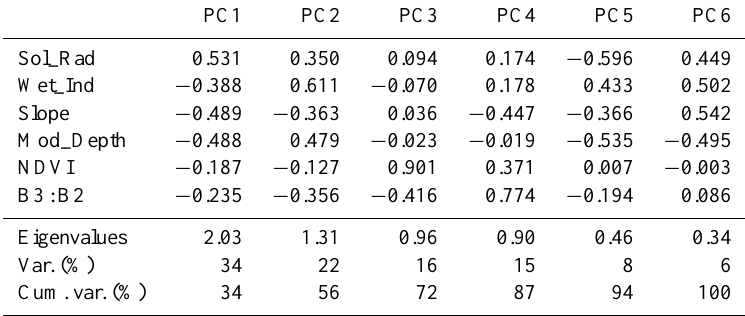
Table 4. Eigenvectors, variance, and cumulative variance for final